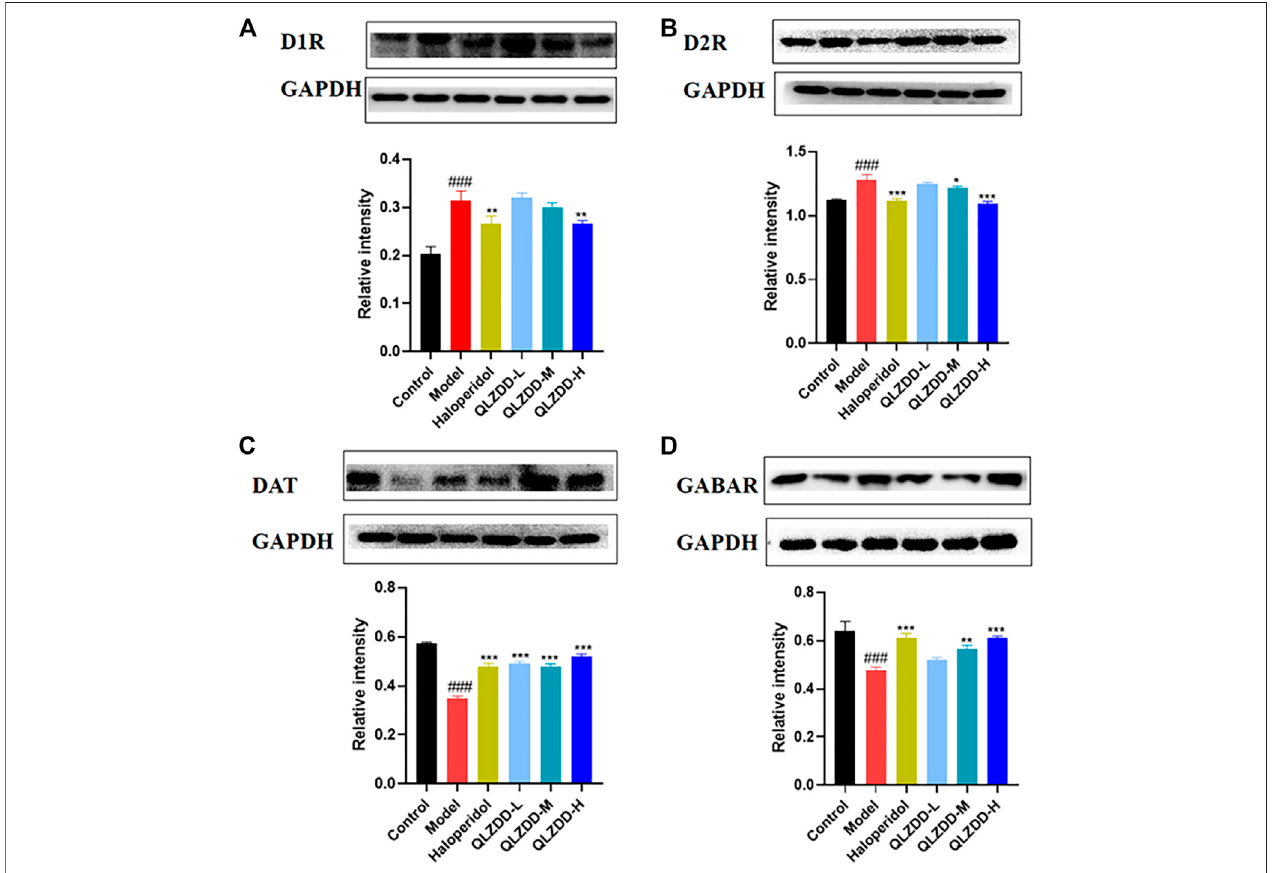
FIGURE5| TheeffectofQLZDDontheproteinexpressionofD1R,D2R,DAT,andGABAR. (A) TheleveloftheD1Rproteinexpressioninserum, (B) thelevelofthe D2R protein expression in serum, (C) the level of the DAT protein expression in serum, and (D) the level of the GABAR protein expression in serum. All data were expressed as mean ± SD ( n = 3 mice). One-way ANOVA was used to compare the data of the QLZDD groups with the data of the control group. ### p < 0.001 in comparison with the model group. * p < 0.05, *** p < 0.01, and *** p < 0.001.